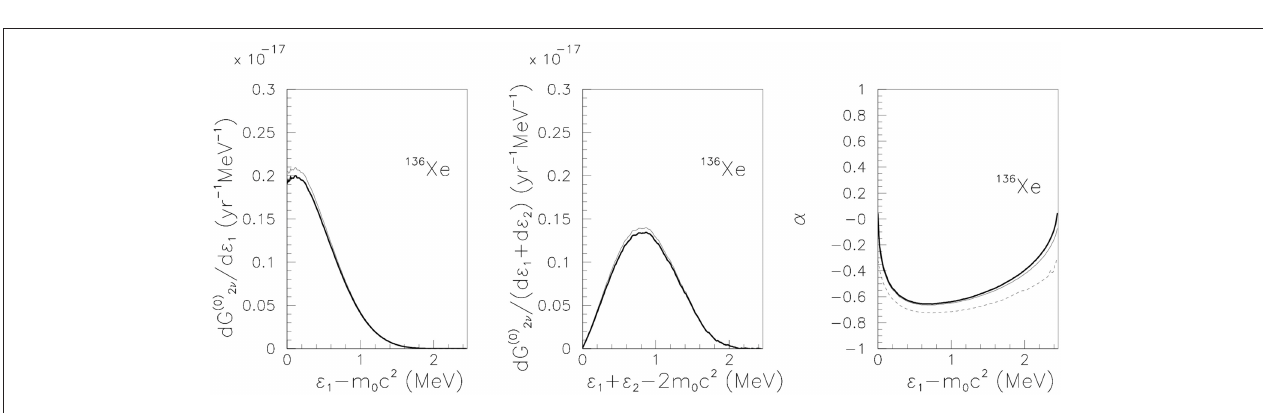
FIGURE 5 | Same as Figure 4 for the 136 Xe parent nucleus.